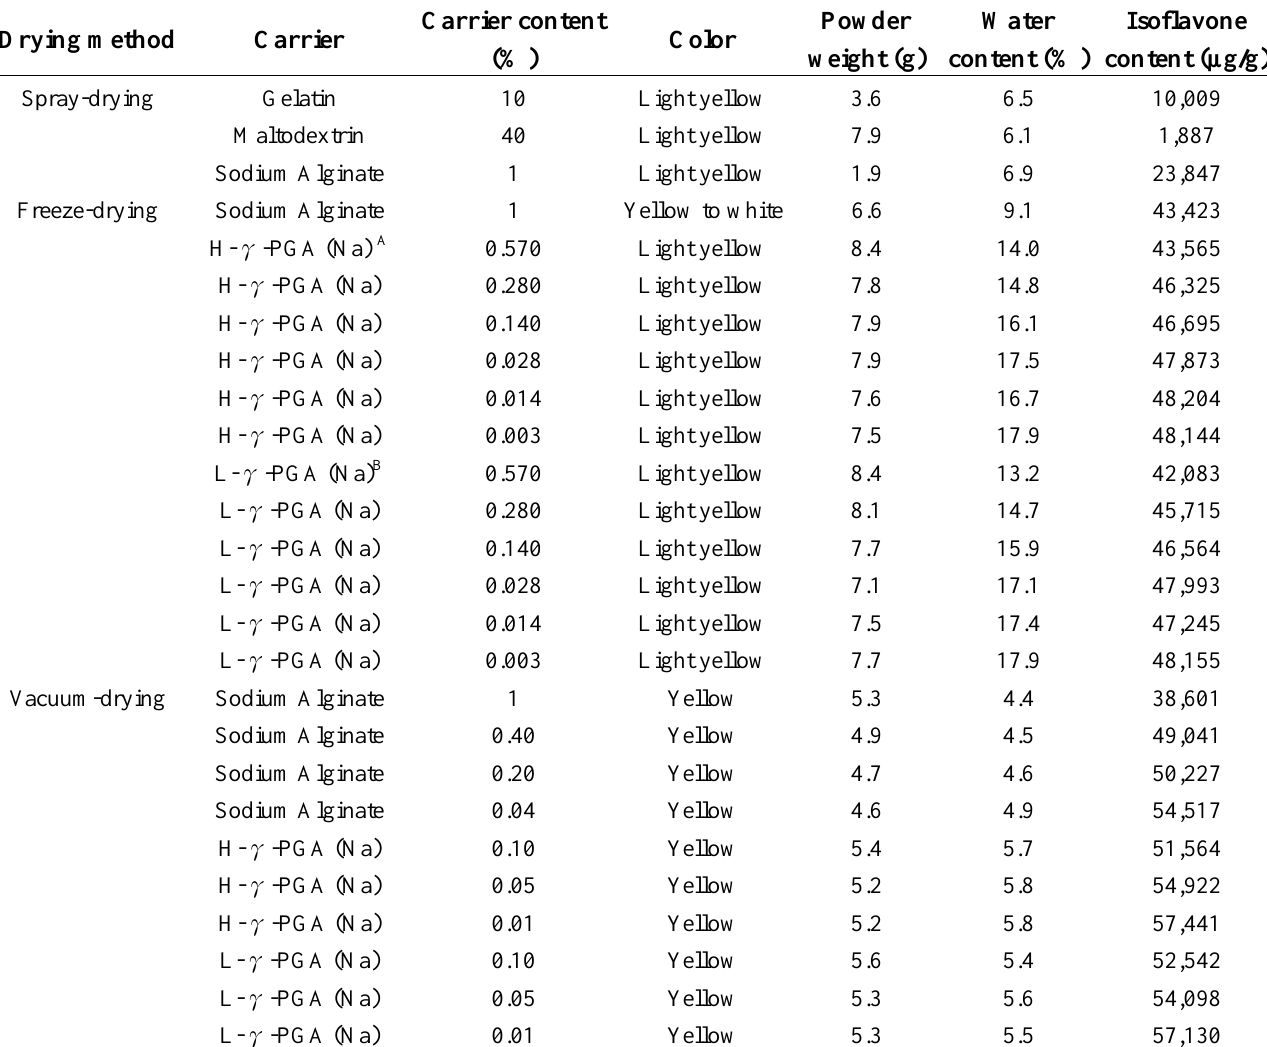
Table 6 . Characteristics of the various isoflavone powder made by different drying